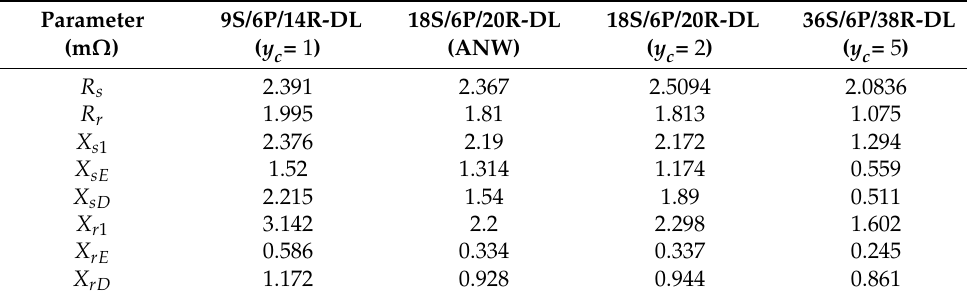
Table 2. Comparison of the resistance and reactance data at a rated